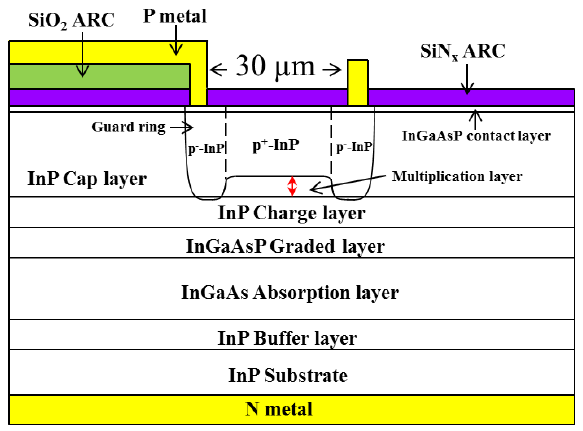
Figure 1. Schematic diagram showing the epitaxial layer structure of the proposed InP-based avalanche photodetector (APD) based on separate absorption, grading, charge, and multiplication (SAGCM).